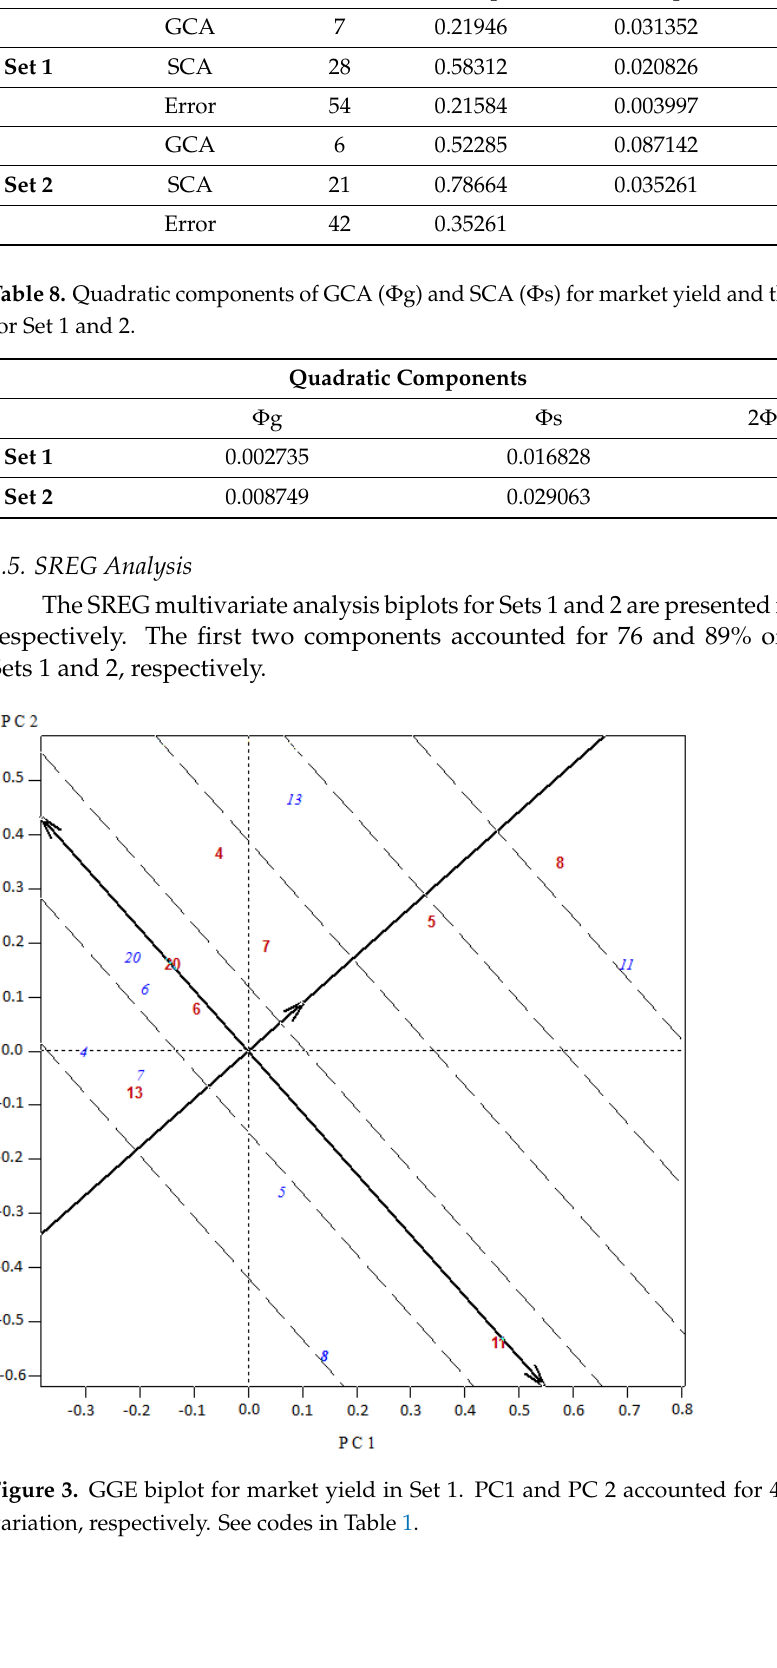
Figure 4. GGE biplot for market yield in Set 2. PC1 and PC 2 accounted for 63% and 26% of the variation, respectively. See codes in Table 1. 3.6. Correlation between Heterosis and Genetic Distance The genetic distance data obtained from SRAP markers analysis are presented in Supplementary Table S2. The correlations between heterosis and the genetic distances of the parents for both sets are presented in Table 9. There was not a significant association between them.